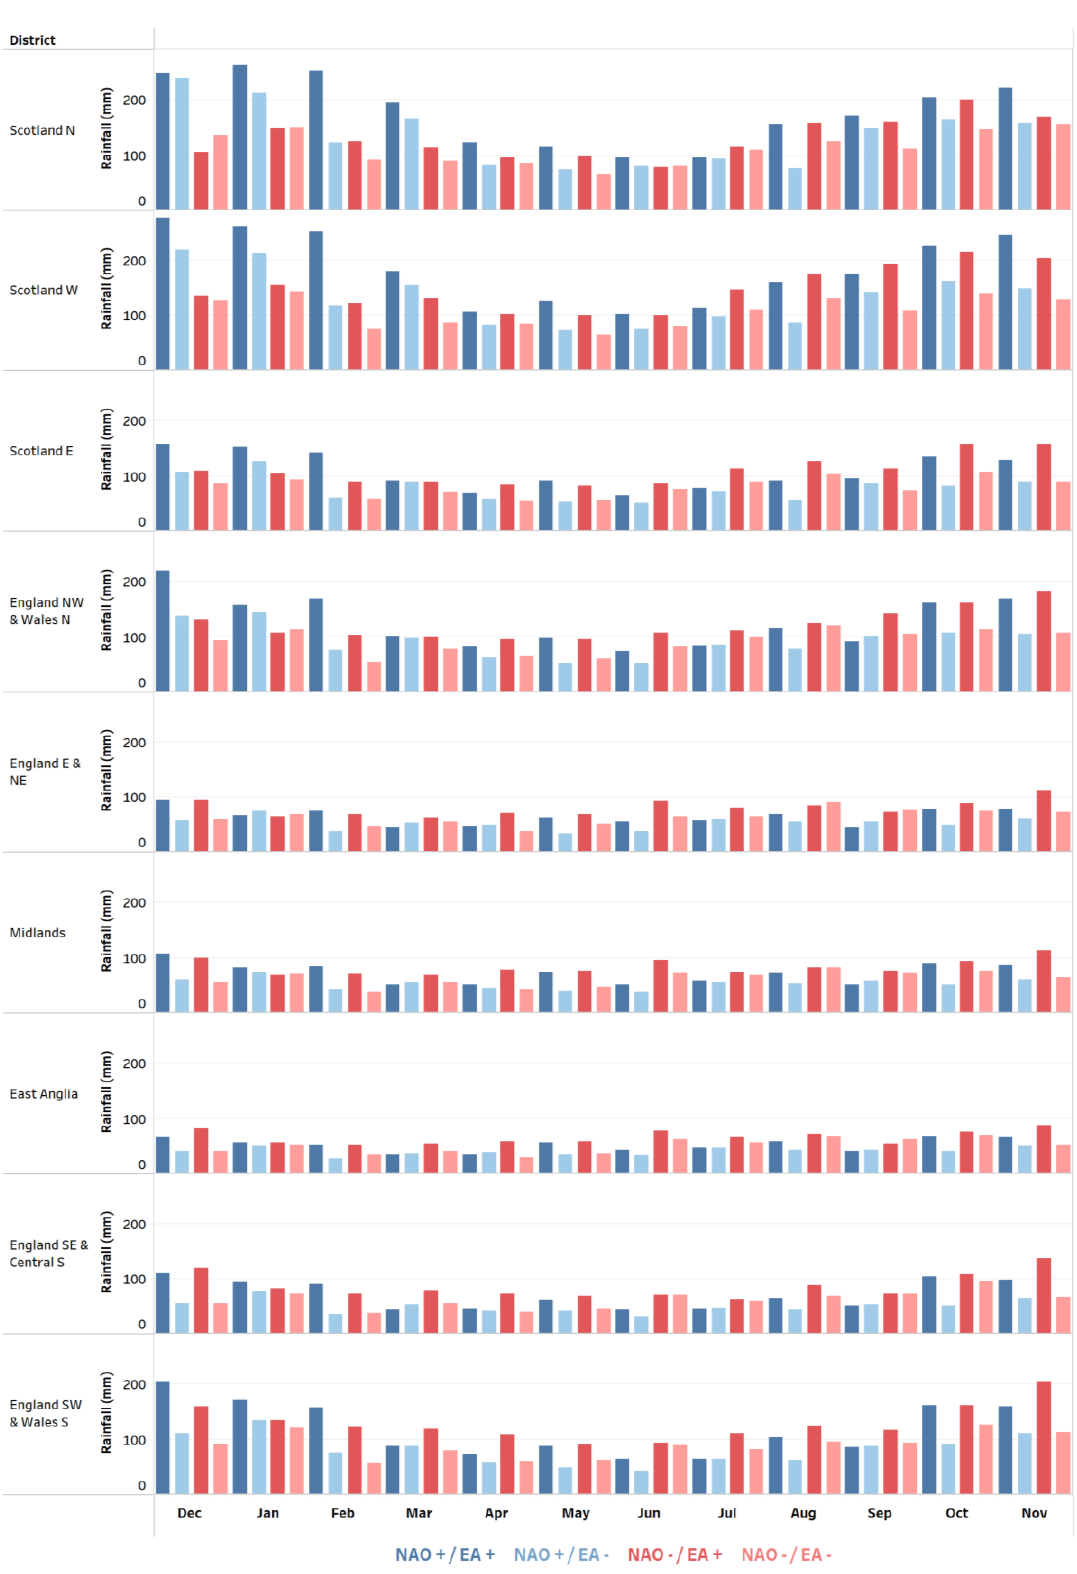
Figure 3. Monthly average rainfall (based on the CEH GEAR dataset) for each NAO/EA phase combination for the nine Met Office Climate Districts.